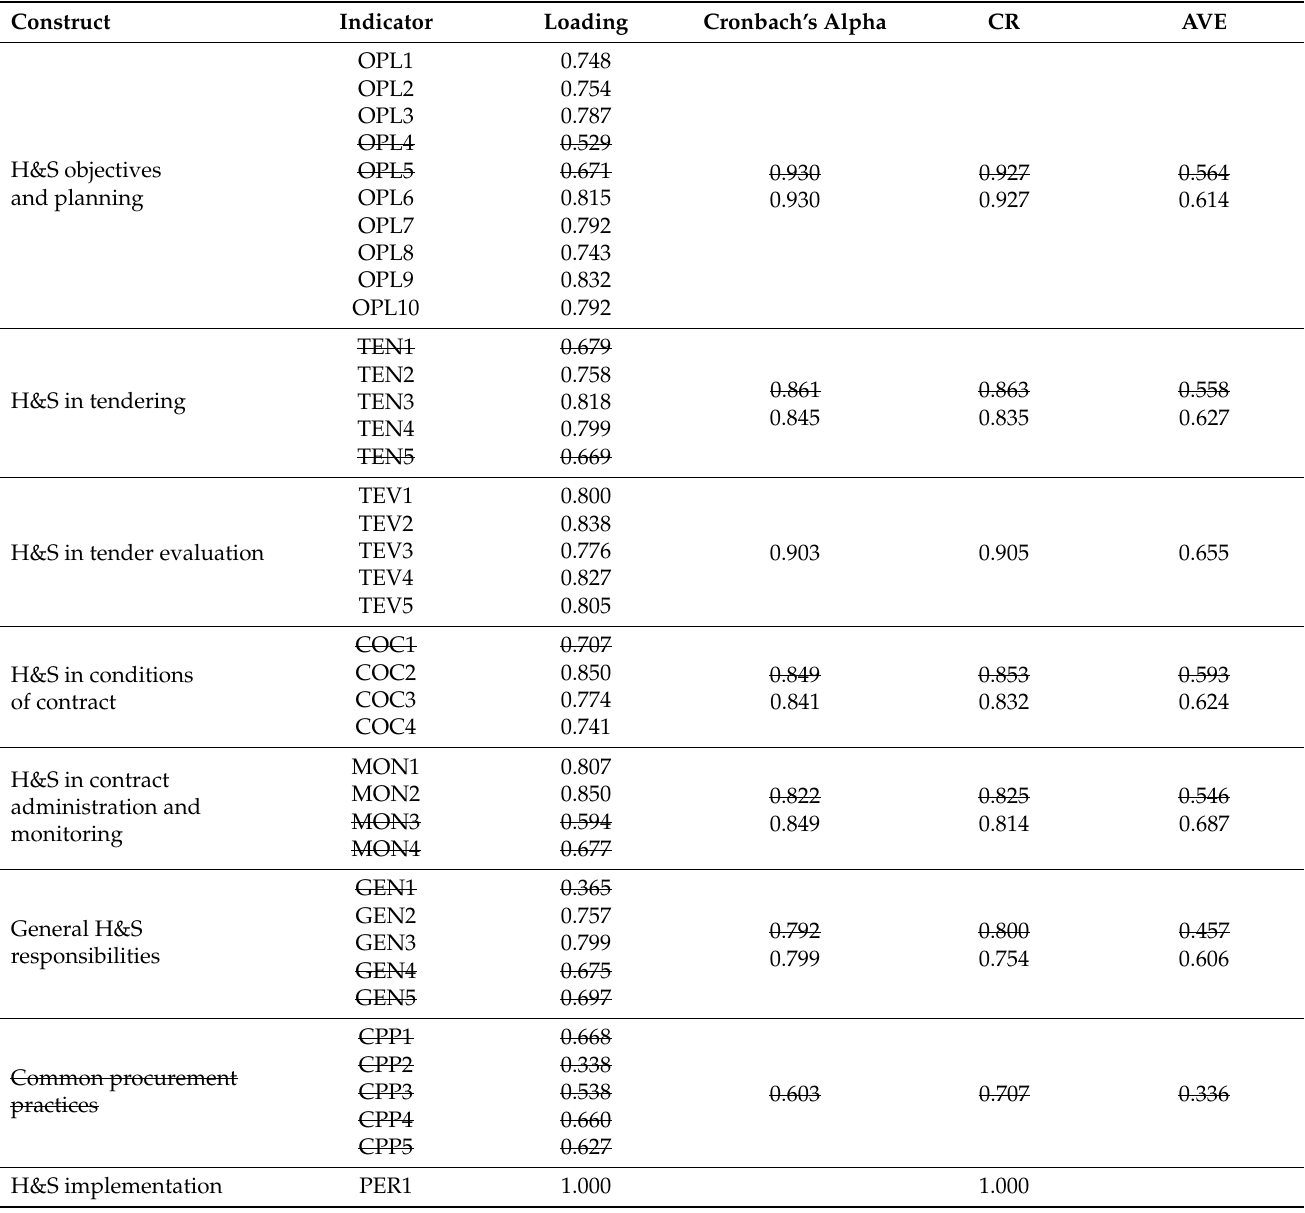
Table 2. Reliability and validity of